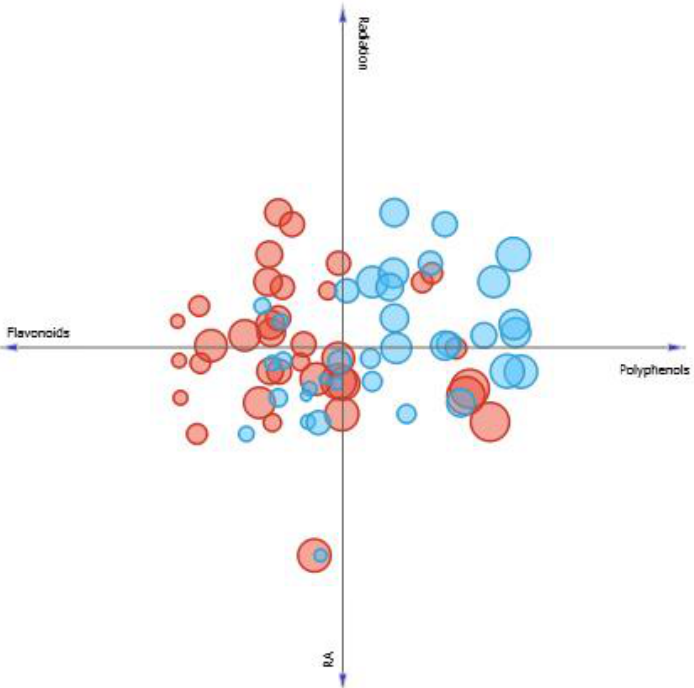
Figure 8. Linear projection correlating the content of phenolics, flavonoids and rosmarinic acid of M. villosa (blue circles) and P. amboinicus (red circles) to solar radiation. Circles size correspond to a greater or lesser SPF value found.